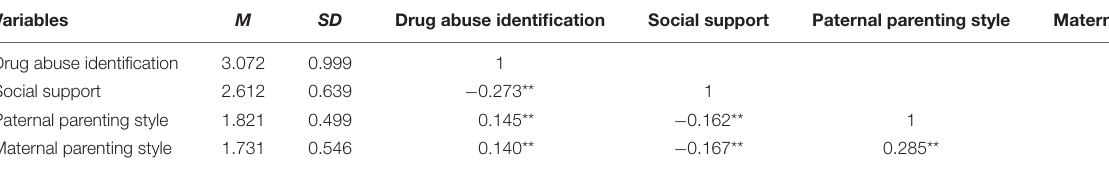
TABLE 2 | Correlations, means, and standard deviations of the main study